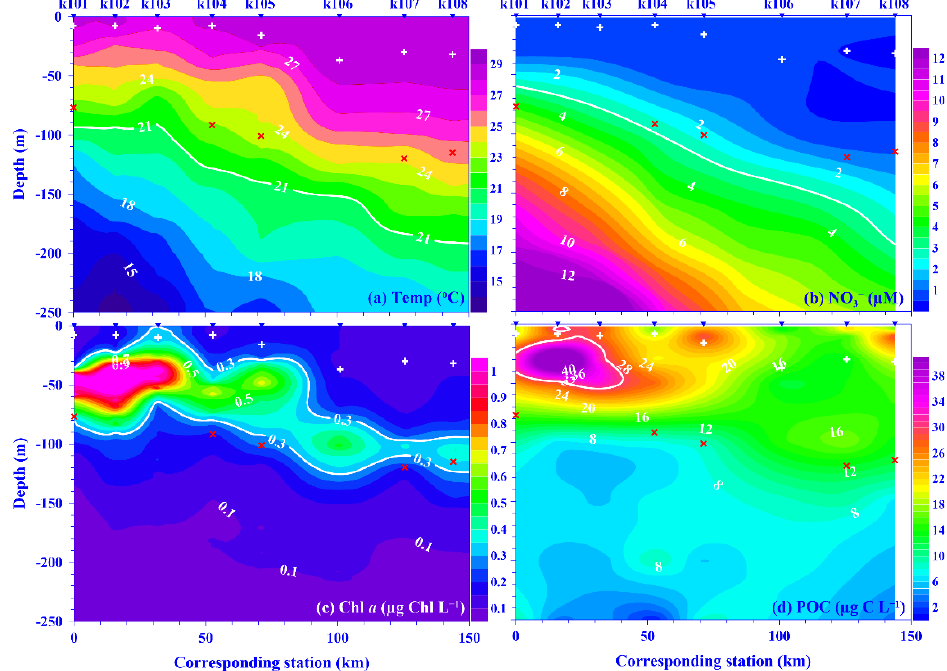
Figure 2. Typical depth profile contour plots of ( a ) temperature (Temp; °C), ( b ) nitrate (NO 3 − ; μ M), ( c ) chlorophyll a (Chl a ; μ g Chl L − 1 ), and ( d ) particulate organic carbon (POC; μ g C L − 1 ) within 250 m water depth along the KTV1 transect in September 2015. Contour lines in white bold are guidelines, including temperature (21 °C), nitrate (1 μ M), Chl a (0.3 μ g Chl L − 1 ), and POC (30 μ g C L − 1 ). The inverse triangles at the top of each panel indicate the locations of stations k101–k108 along the KTV1 transect. Corresponding distance (=0) start from St. k101. For reference, the depths of mixed layer (+) and euphotic zone ( × ) are also